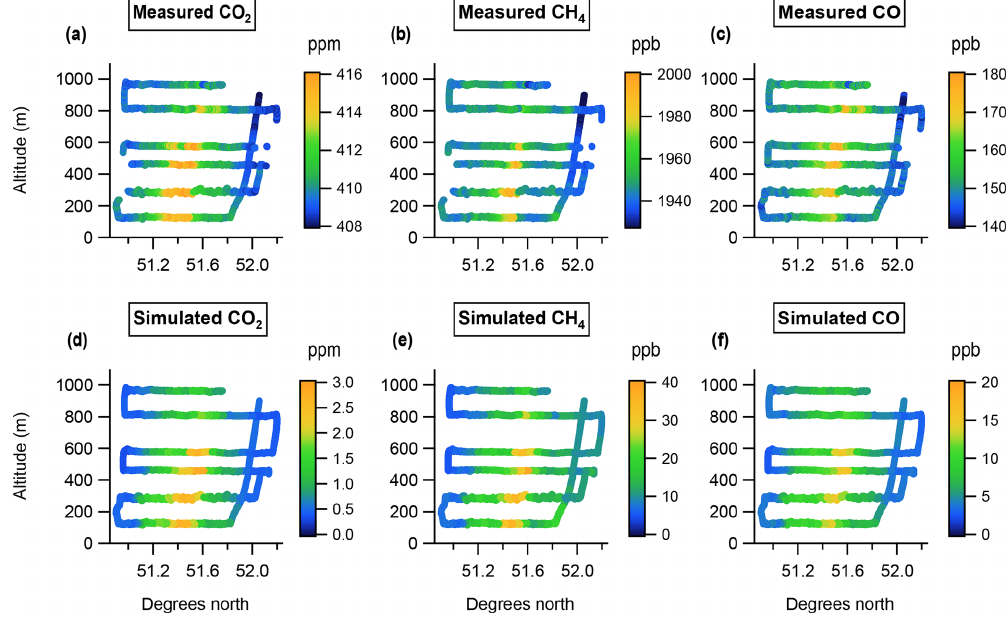
Figure 2. Altitude–latitude projections of measured mole fraction (a–c) and simulated mole fraction enhancement (d–f) downwind of London for each species.